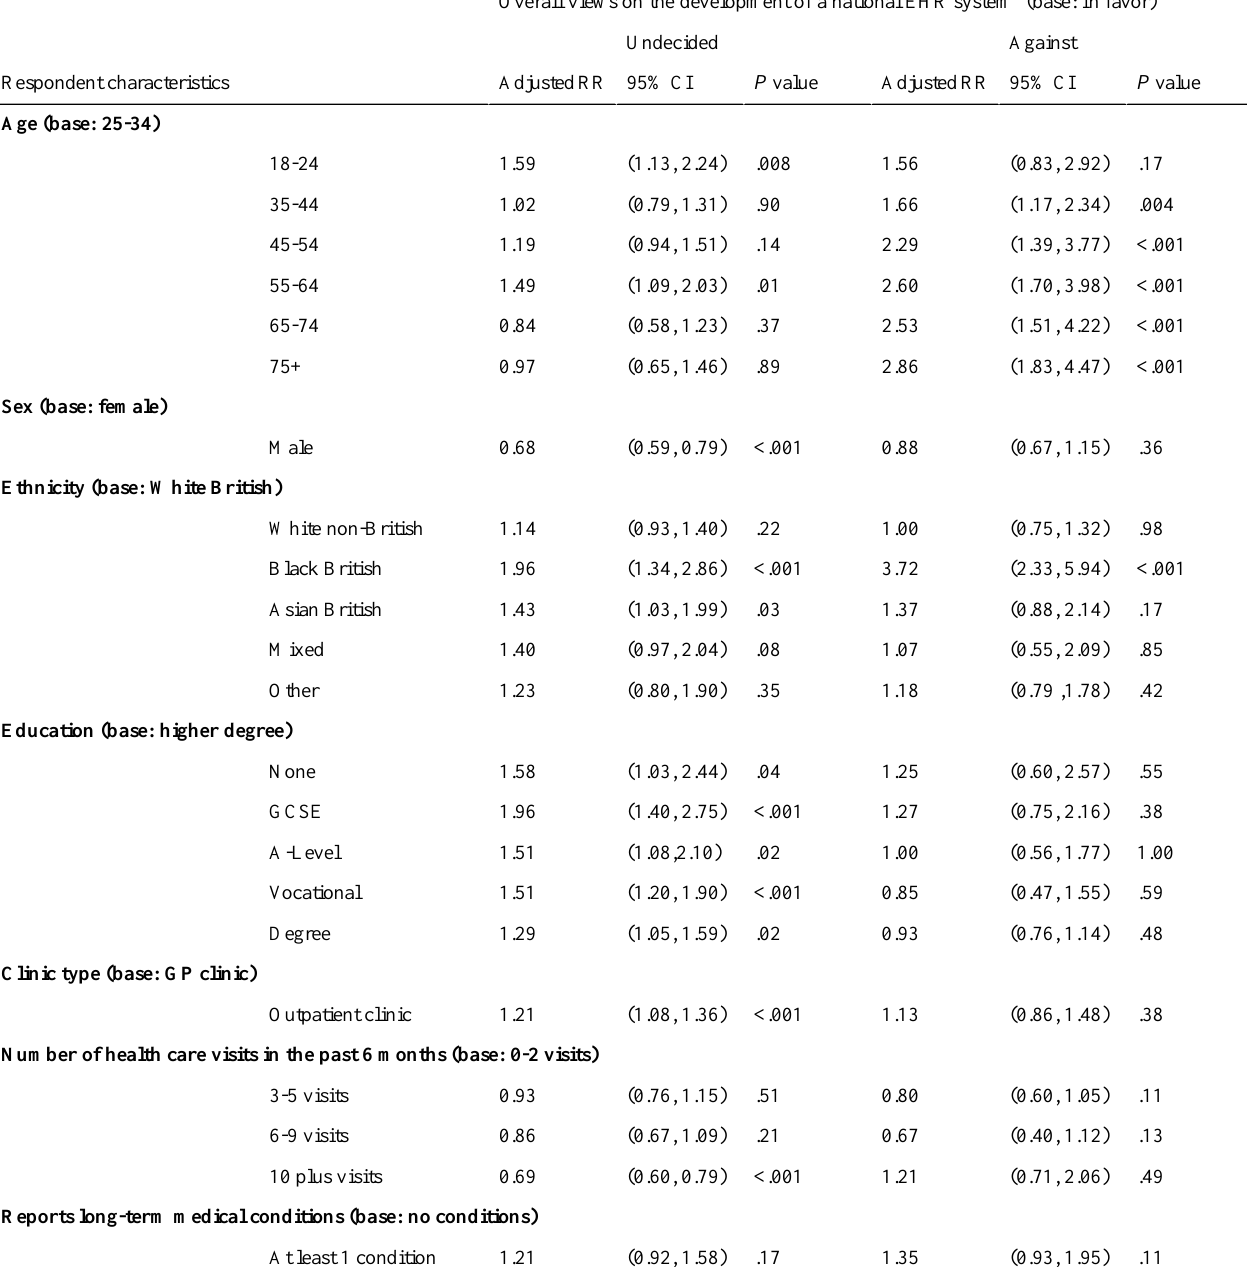
Table 3. Relative risks (RR) indicating associations between overall support for a national EHR system and sociodemographic, health, and health care use characteristics. Multinomial logistic regression model comparing those that would support the development of EHRs overall (base=Yes), compared with those who are undecided and those who would not support EHRs; P values and 95% CI adjusted for clustering by sampling site (N=2857). Overall views on the development of a national EHR system a (base: In